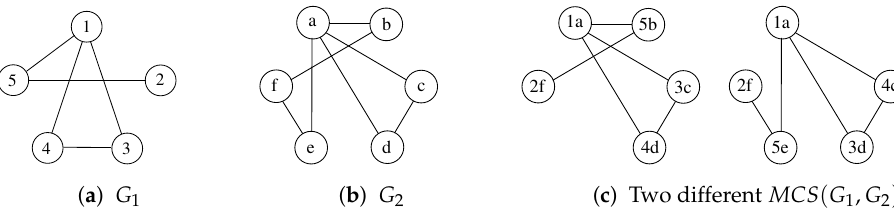
Figure 1. Given the graphs G 1 and G 2 represented in ( a , b ), ( c ) reports two different admissible MCSs. Labels are shown only to help identify the vertices.